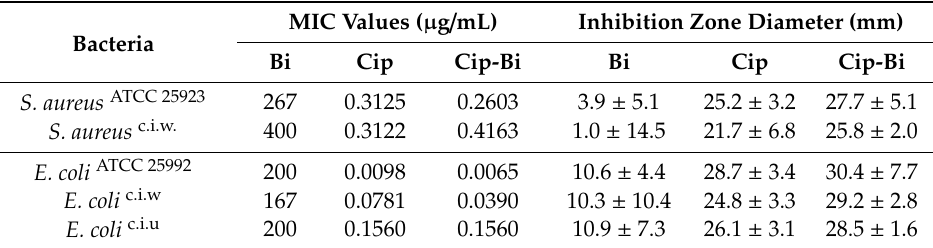
Table 2. Minimal inhibitory concentrations (MICs) and zones of inhibition determined for the solutions of ciprofloxacin (Cip), bismuth citrate (Bi) and ciprofloxacin-bismuth complex (Cip-Bi); mean ± relative standard deviation %, n = 5.